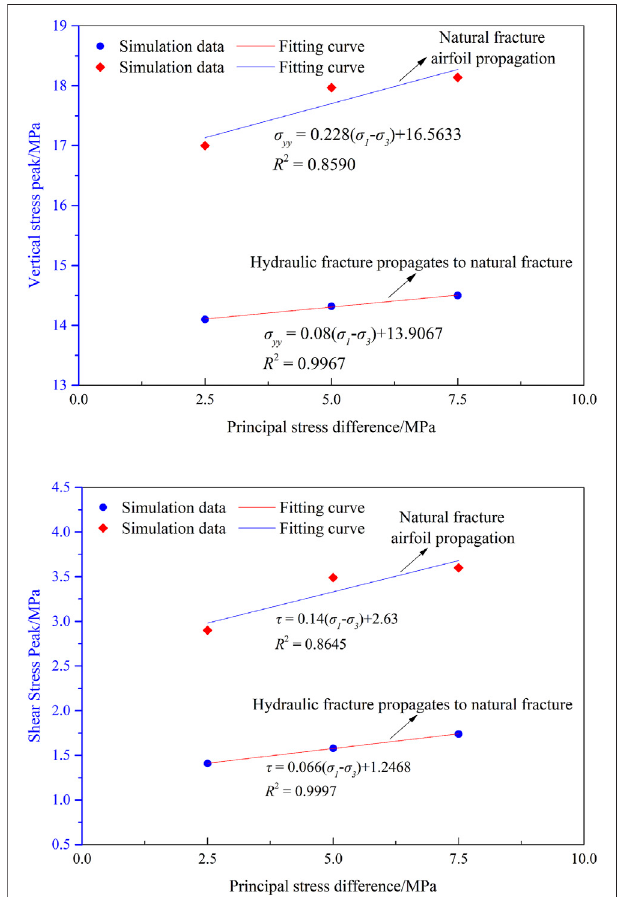
FIGURE 11 | The distribution of fl uid pressure, vertical stress, and shearing stress during hydraulic fractures propagation under different cohesive of natural fracture. (A) First failure of natural fractures; (B) airfoil propagation of natural